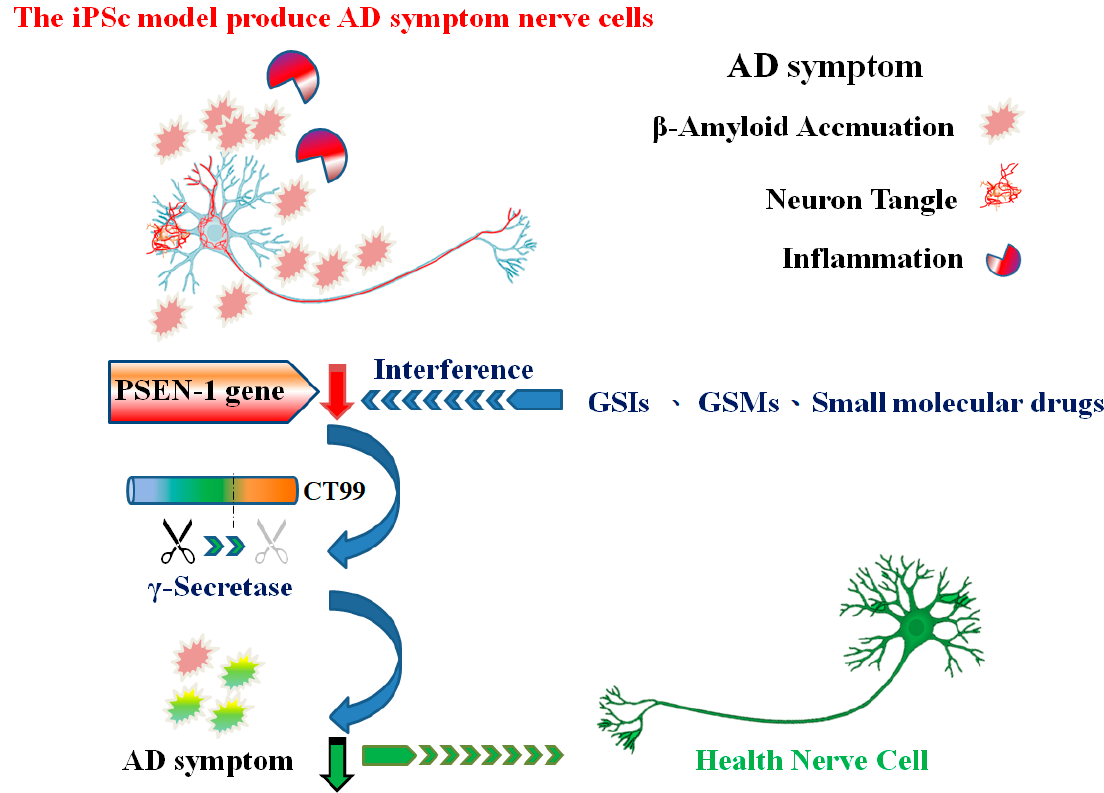
Figure 7. The iPSC screen drug strategy of Alzheimer’s disease. The AD-iPSC cell model can produces different AD symptoms, including β -amyloid accumulation, nerve entanglement, and inflammatory response. iPSCs have be customized according to personalization and, through various different treatment strategies, the treatment effect can be achieved more efficiently. AD = Alzheimer’s disease, GSI = γ -secretase inhibitors, GSM = γ -secretase modulators, and iPSC = induced pluripotent stem cell. Funding: Buddhist Tzu Chi Medical Foundation TCMF-SP